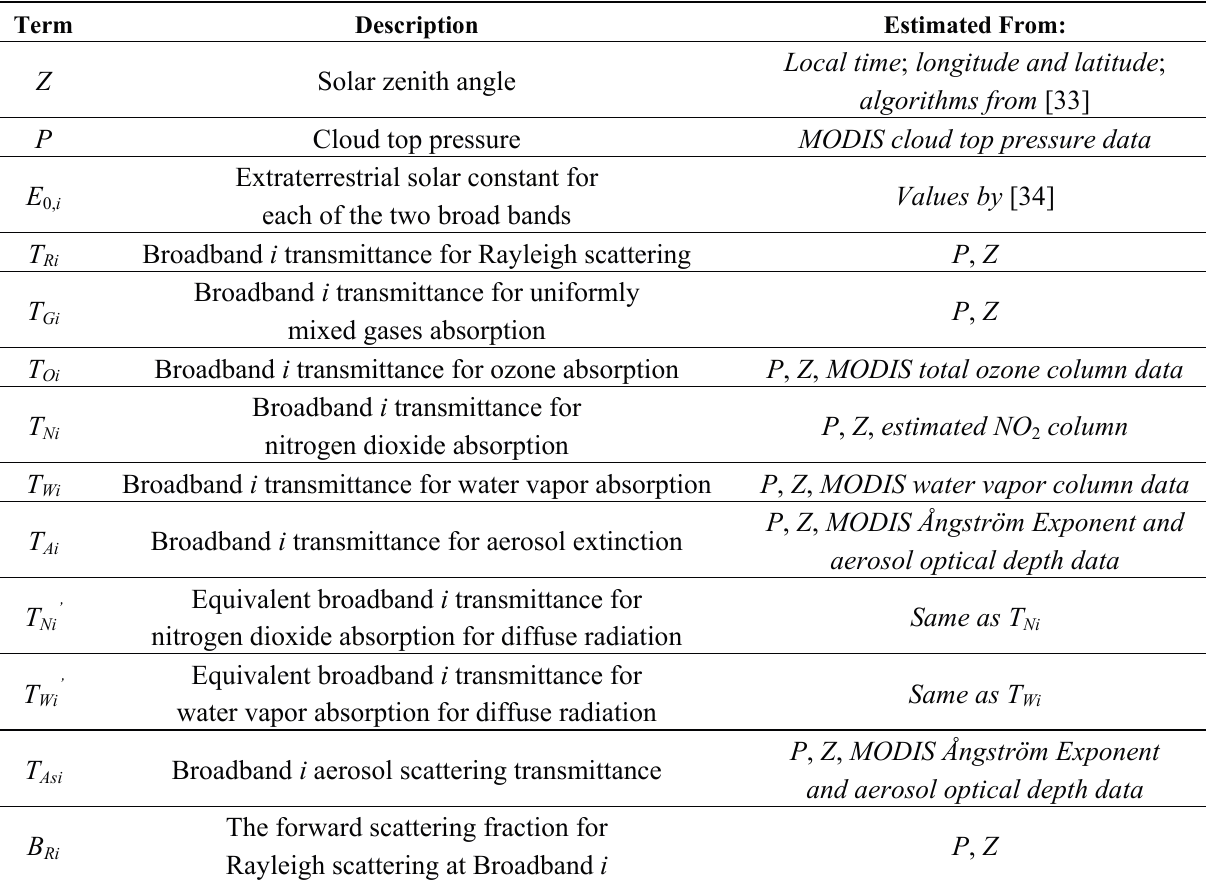
Table 1. Key variables in the computing